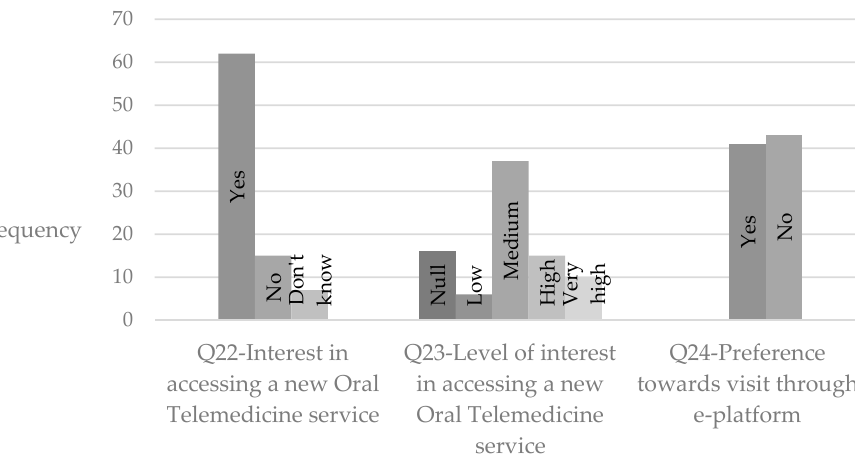
Figure 2. Reported interest in tele(oral) medicine service by study subjects. Tables 2 and 3 show the results of the bivariate statistical analysis carried out, consid- ering Q22 and Q23 as dependent variables, respectively. Table 2. Summary of bivariate analysis carried out considering Question 22 as a dependent variable.